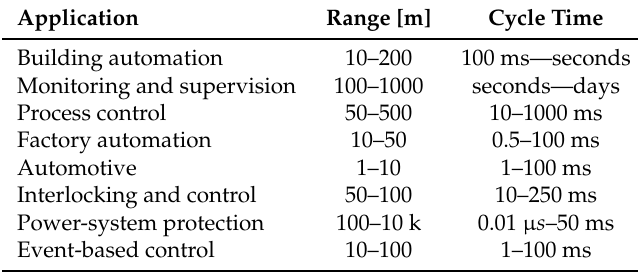
Table 1. Cycle time and communication range requirements broadly vary over industrial automation use-cases [12,24–26].